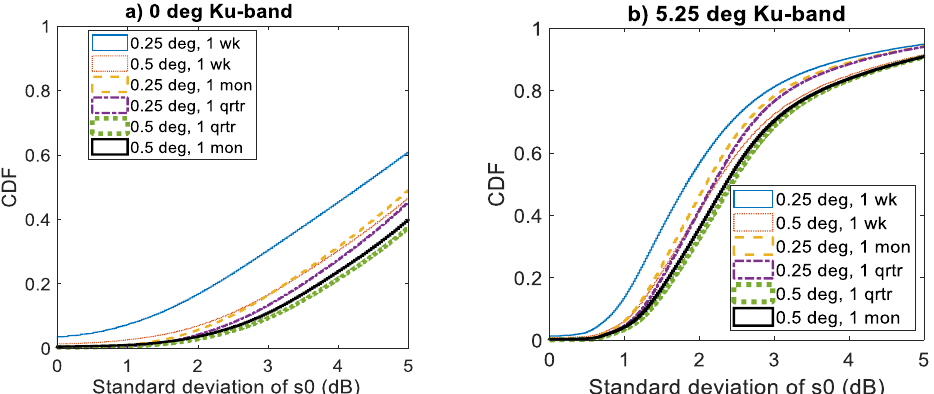
Figure 3. Ku- band σ ° cumulative distribution function (CDF) for the SSD for different types and amounts of averaging. ( a ) CDF for nadir σ °. ( b ) CDF for σ ° at 5.25° incidence. Horizontal axis is SSD. ( a ) CDF for nadir σ ◦ . ( b ) CDF for σ ◦ at 5.25 ◦ incidence. Horizontal axis is